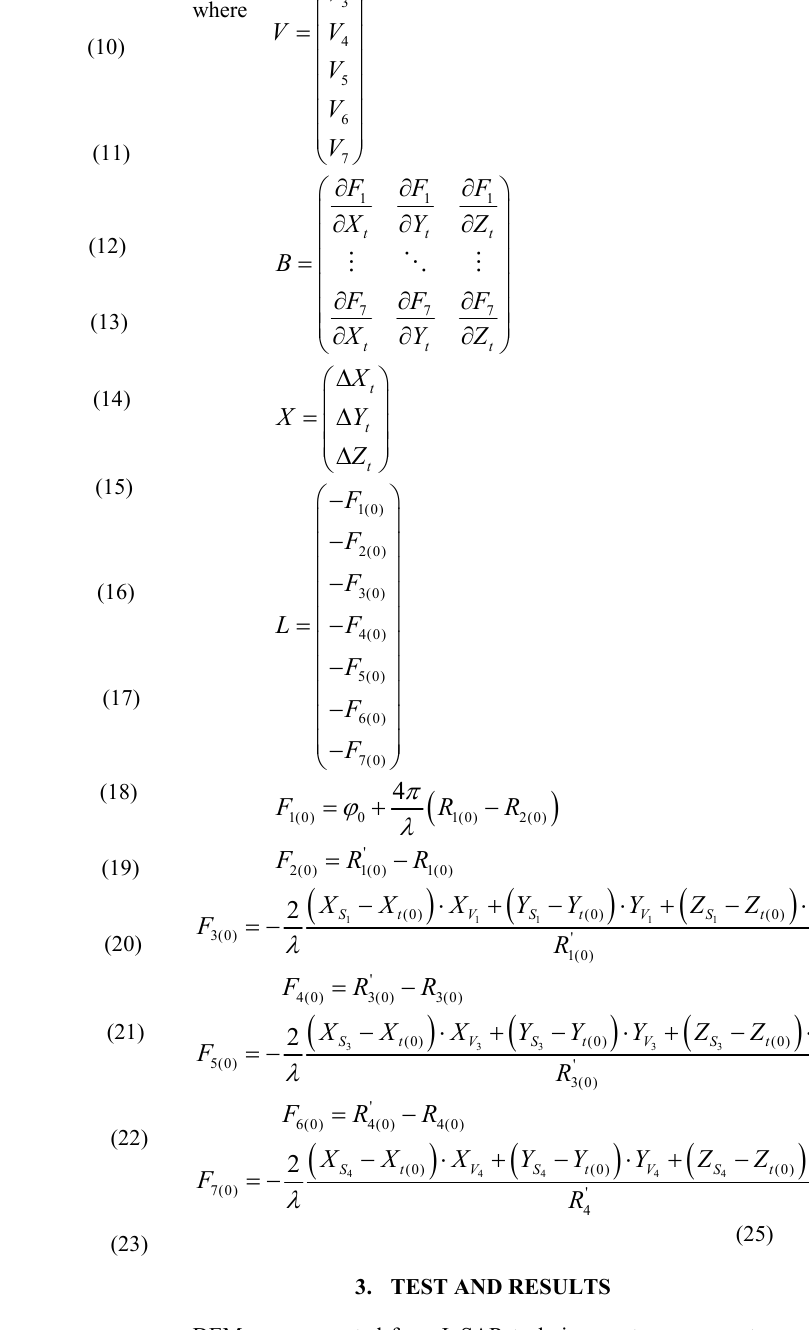
DEMs are generated from InSAR techniques, stereogrammetry techniques and combined techniques in Deqin, Yunnan Province. InSAR related results are shown in figure 2 including DEM, layover and shadow mask and coherence map. DEM extracted through ascending stereogrammetry and descending stereogrammetry are shown in figure 3. Combined adjustment results are shown in figure